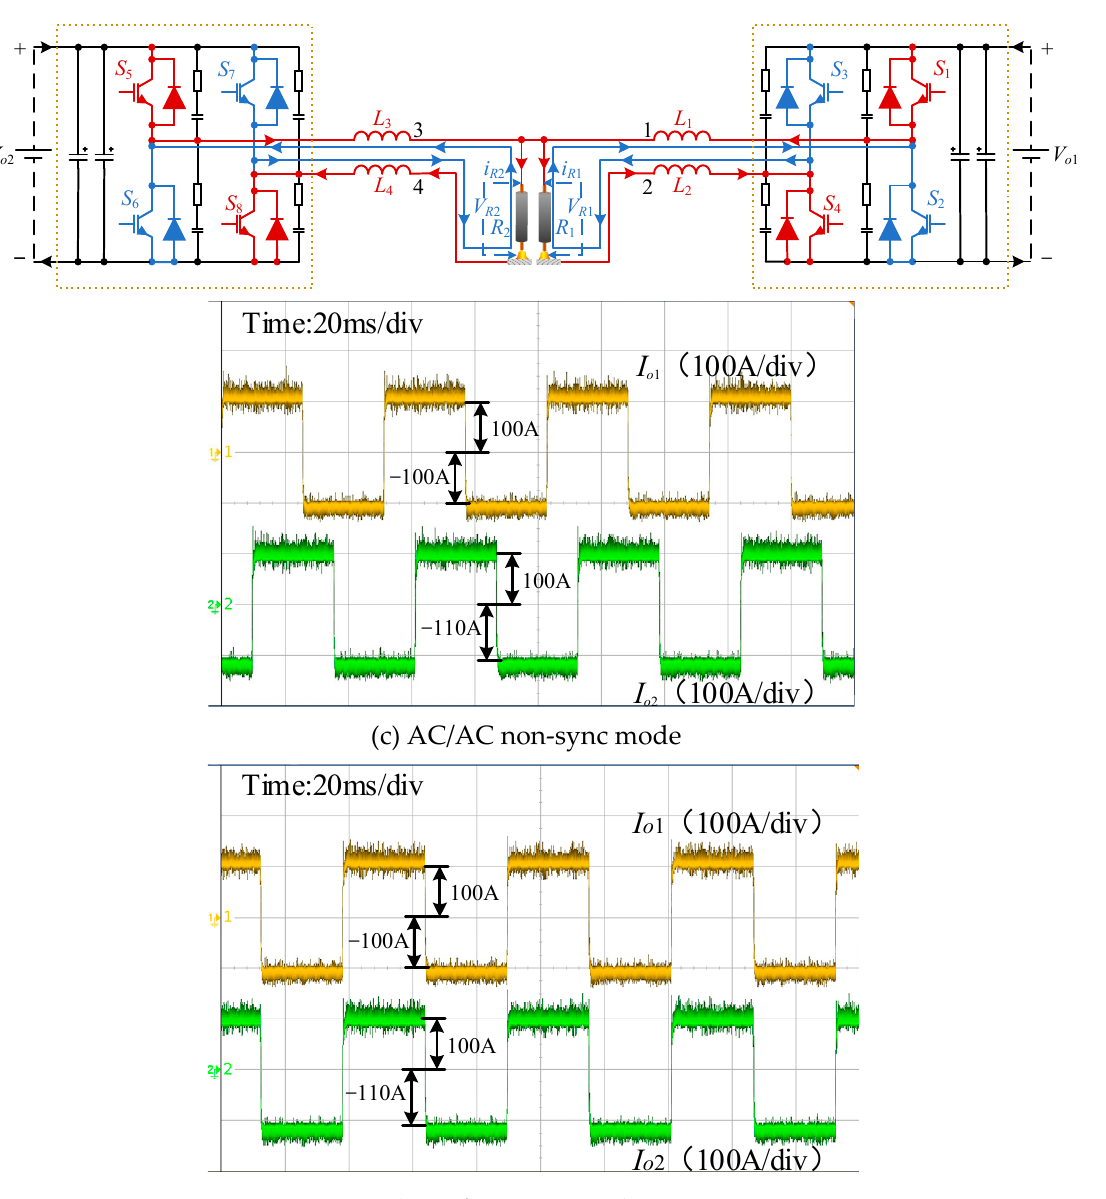
Figure 13. Experiment waveforms.